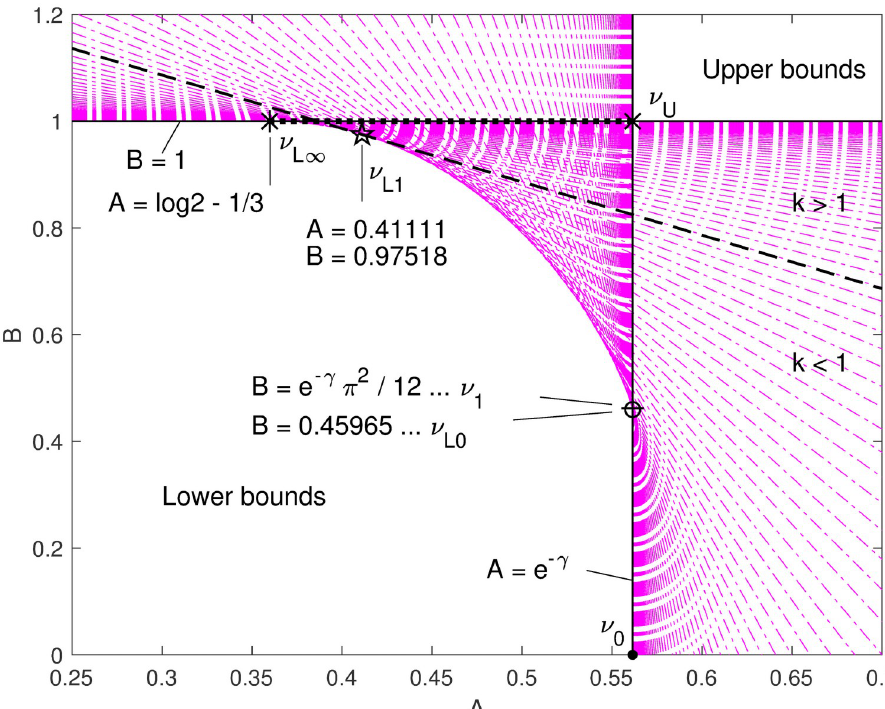
Fig 3. Parameter space. The A – B parameter space is shaded with dash-dot lines where ν ( k )2 1/ k = A + Bk , for a set of very small to very large k values in geometric progression (using numerically computed ν ( k ) values). Key values of A and B are indicated. Points outside (or on the edge) of the shaded region represent bounds, while points inside the shaded region represent functions that cross the median function. There is an obvious uniquely tight upper bound ν U , and a curved locus of tight lower bounds from ν , which is tightest near k = 0, to ν , which is tightest for high k . One L 0 L 1 point (pentagram) on the curved locus represents a lower bound ν L 1 that is tight at k = 1, for which A + B = 2 log 2 (which is the equation of the dashed line). The point ν 1 represents a good asymptotic approximation close to ν , but L 0 not a bound; see the next figure. The dotted line from ν U to ν L 1 at B = 1 intersects the lines for all k in monotonic order, with A decreasing while k